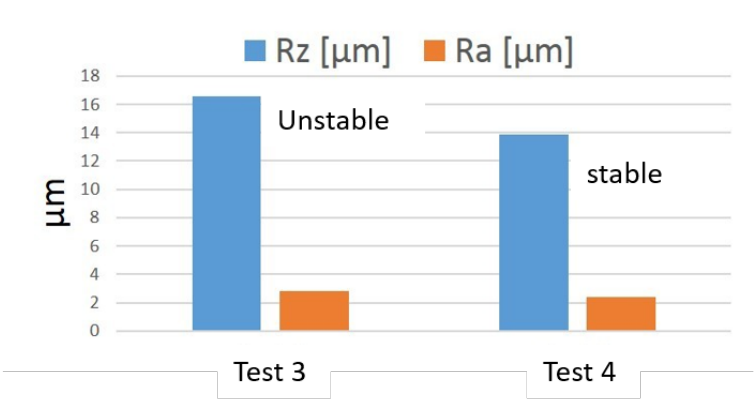
Fig. 12. Roughness in tests 3 and